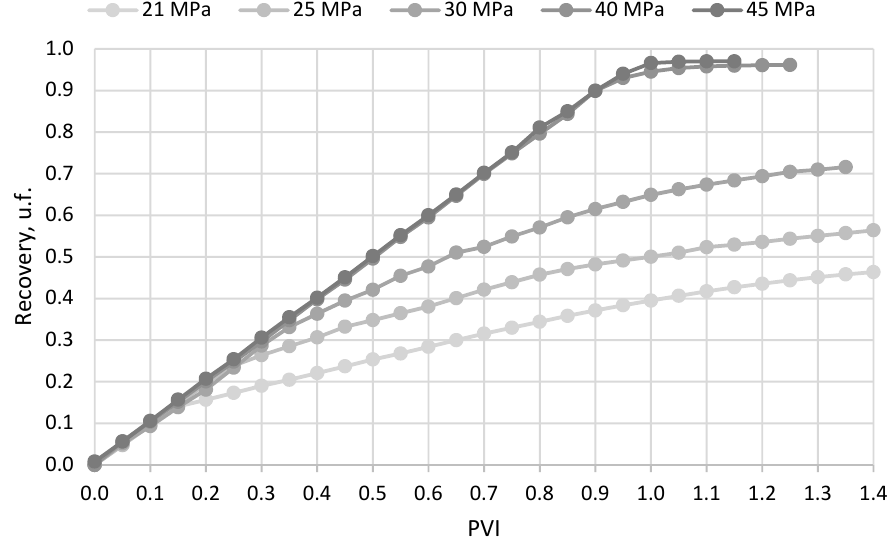
unchanged, and the breakthrough with a sharp increase in the gas–oil ratio occurs at a late stage of displacement. Figure 5. Recovery curves for APG injection at pressures 21–45 MPa. Figure 5. Recovery curves for APG injection at pressures 21–45 MPa.